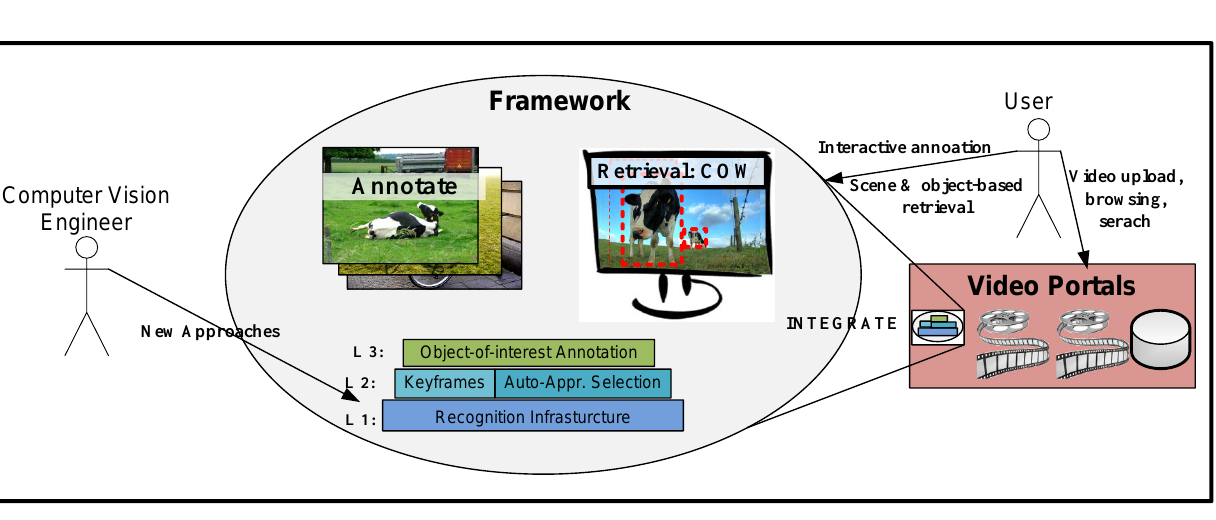
Figure 1. A high-level perspective of the proposed annotation